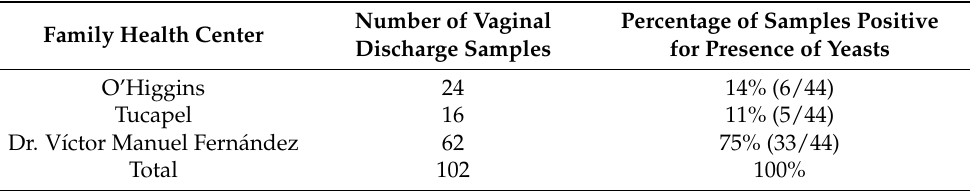
Table 3. Number of samples positive for yeasts in each one of the three Family Health Centers and percentage of positive samples from the total number of positive